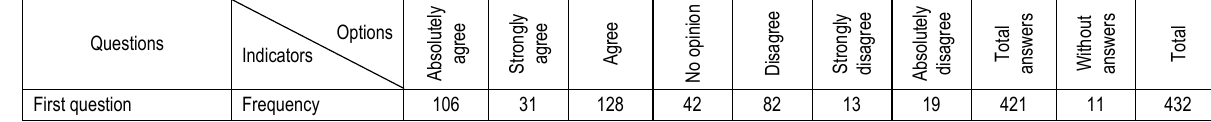
Table 4. Response data description of principals’ to the questions of program and supplementary tasks